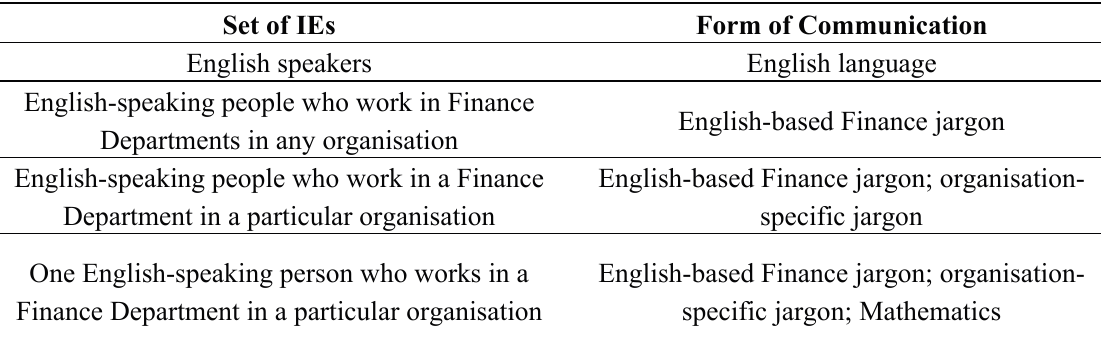
Table 2. IEs and Forms of Communication Examples.